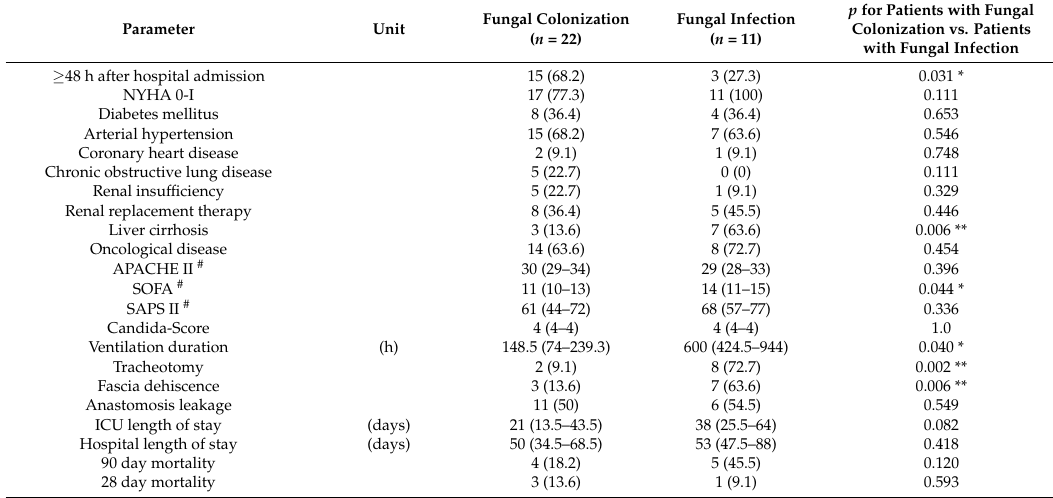
Table 3. Characteristics of patients with or without a fungal infection.